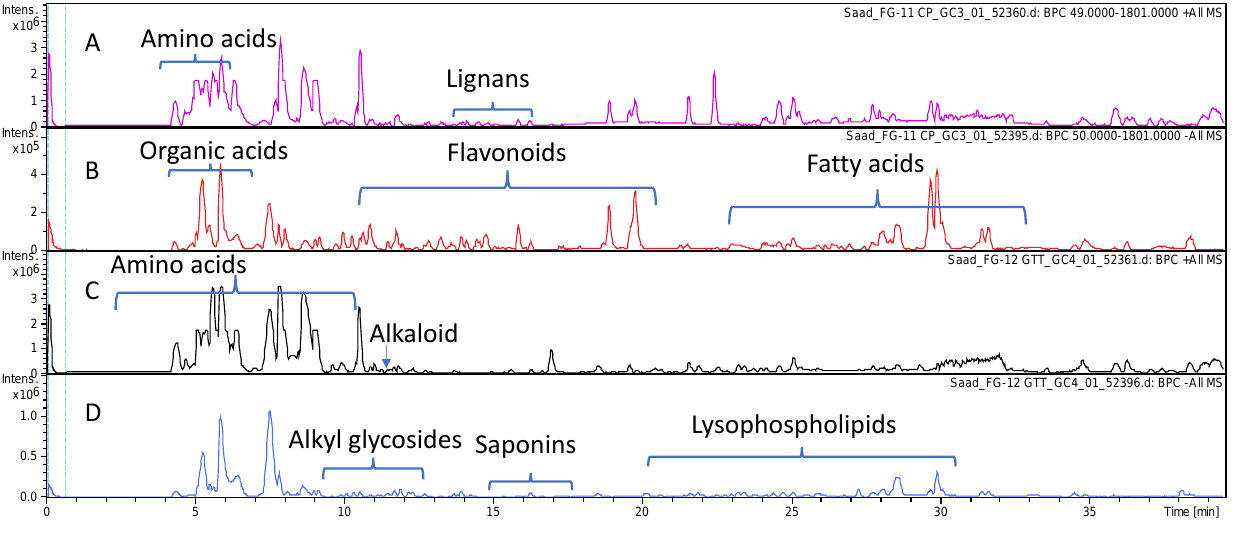
Figure 1. Base peak chromatograms of Lagenaria siceraria ( A , B ) and Cucumis sativus ( C , D ) crude fruit extracts as analyzed via HR-UPLC/MS/MS in both positive ( A , C ) and negative ( B , D ) ionization modes.